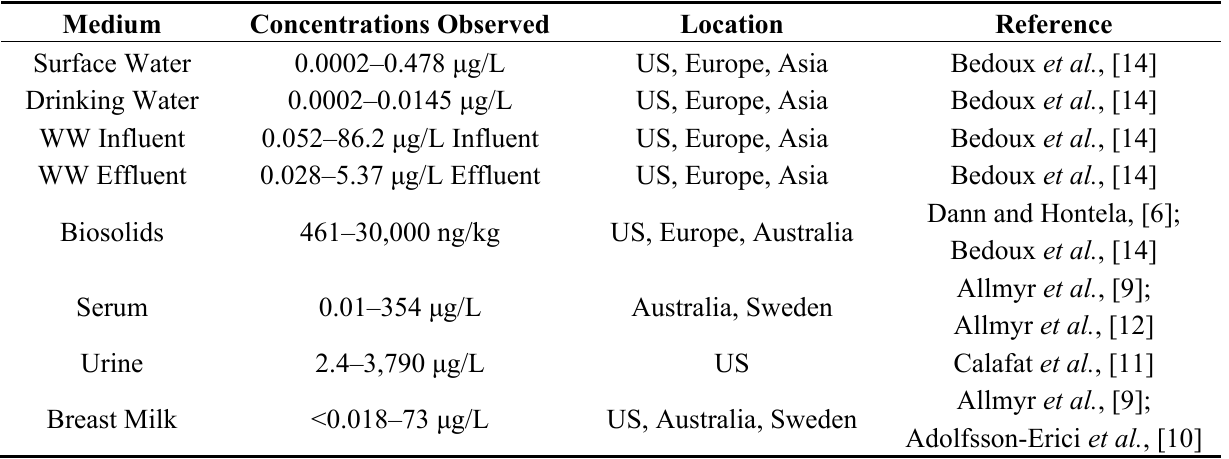
Table 1. Concentrations of triclosan Detected in the Environment.